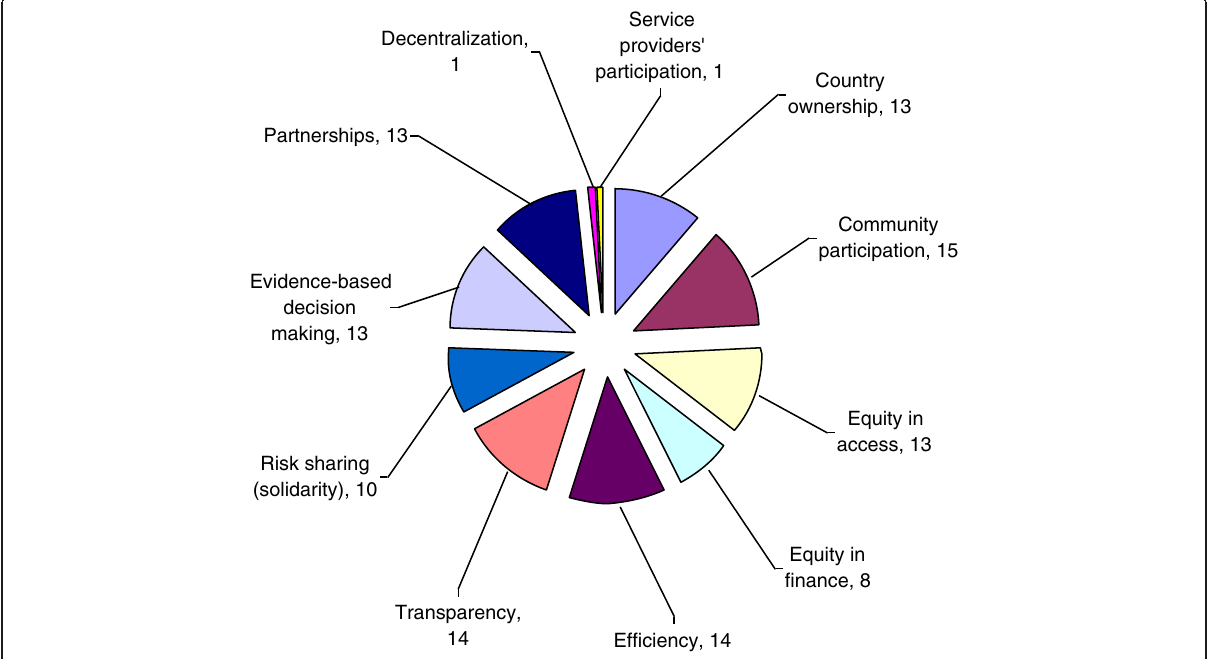
Figure 2 Number of respondents mentioning core values to guide national health financing policy.